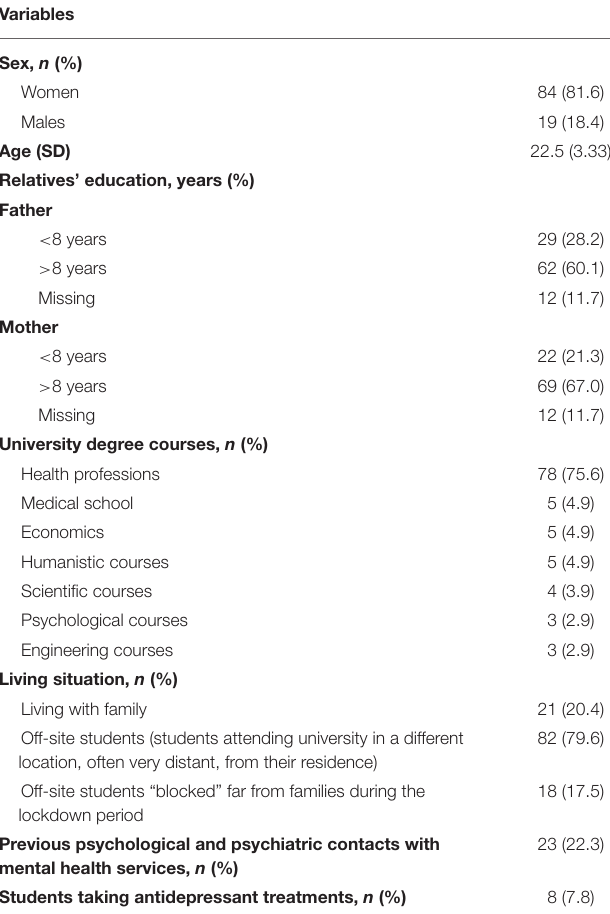
TABLE 1 | Description of the main socio-demographical, living, and clinical conditions of our university students